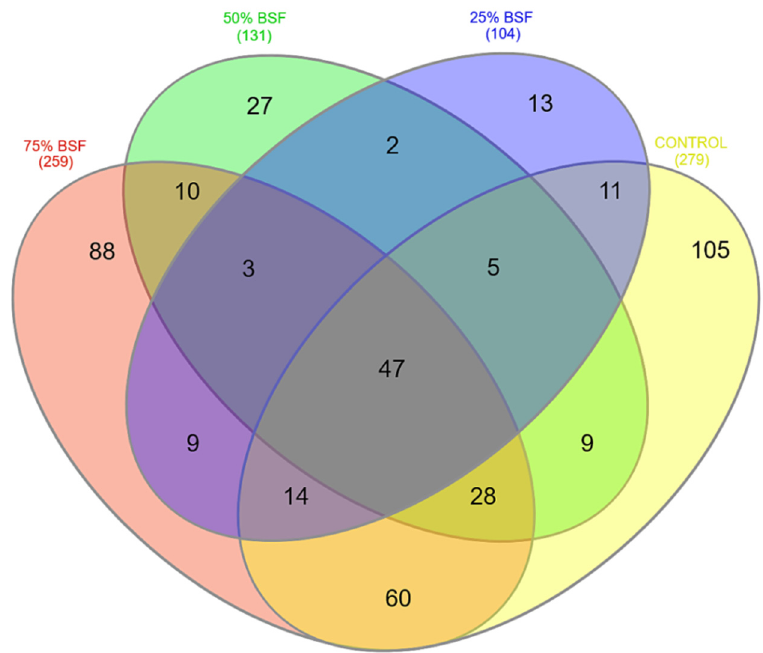
Figure 7. Venn diagram showing the unique and shared bacteria genera between the four dietary treatments.